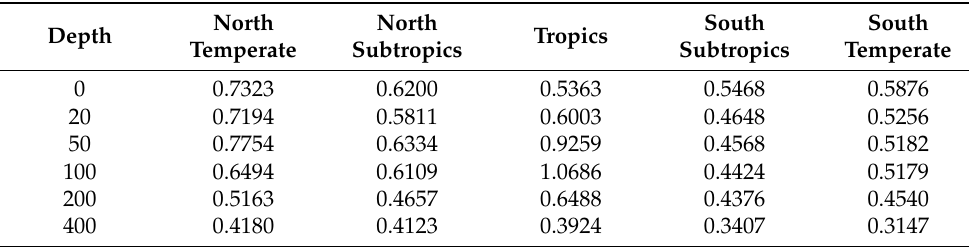
Table 3. RMSE values of the predicted SSbT for selected depth levels over different geographical zones.